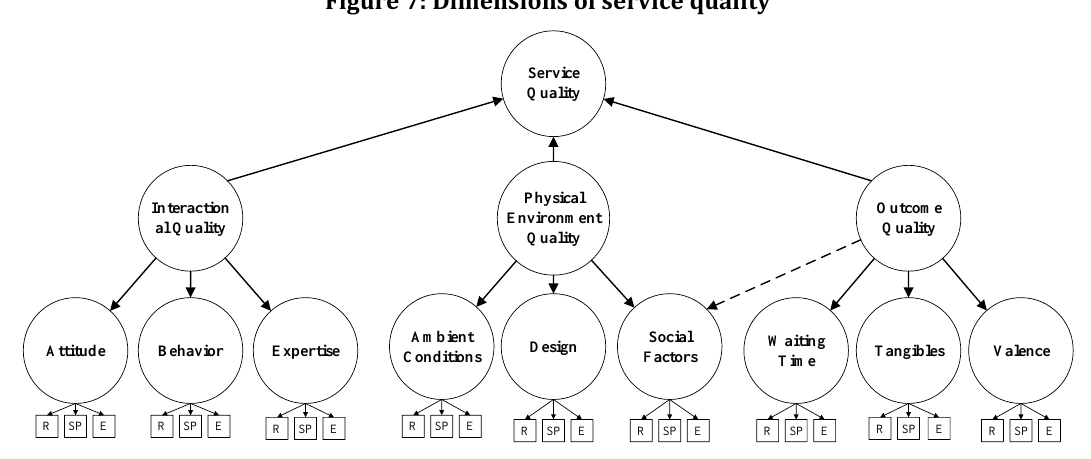
Figure 7: Dimensions of service quality